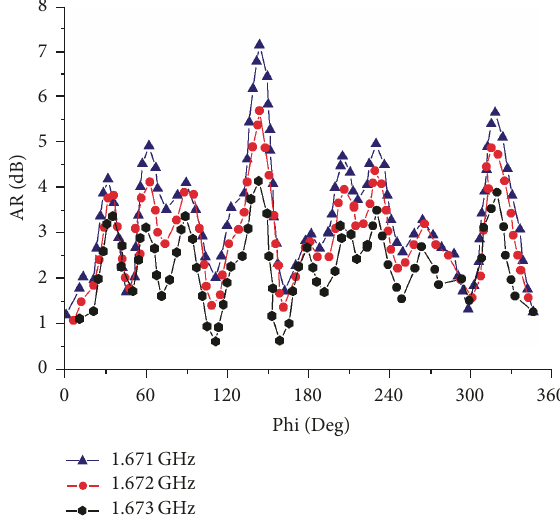
Figure 7: Array axis ratio in the